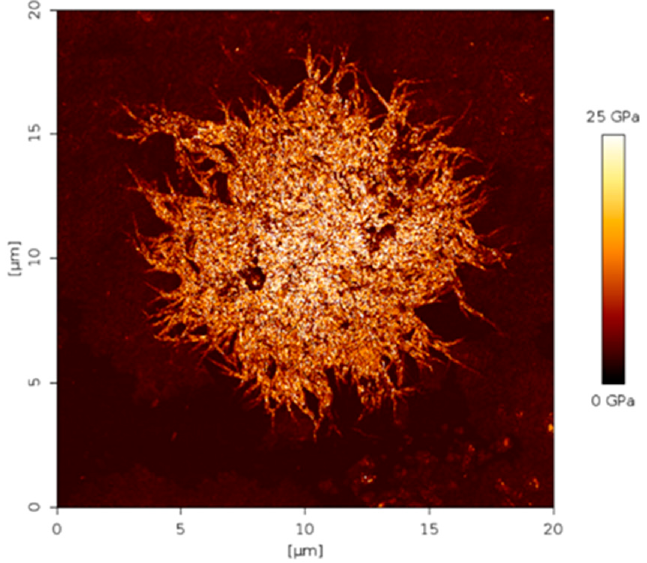
Figure 5. Young’s modulus AFM image of spherulite crystal in PEBAX membrane.